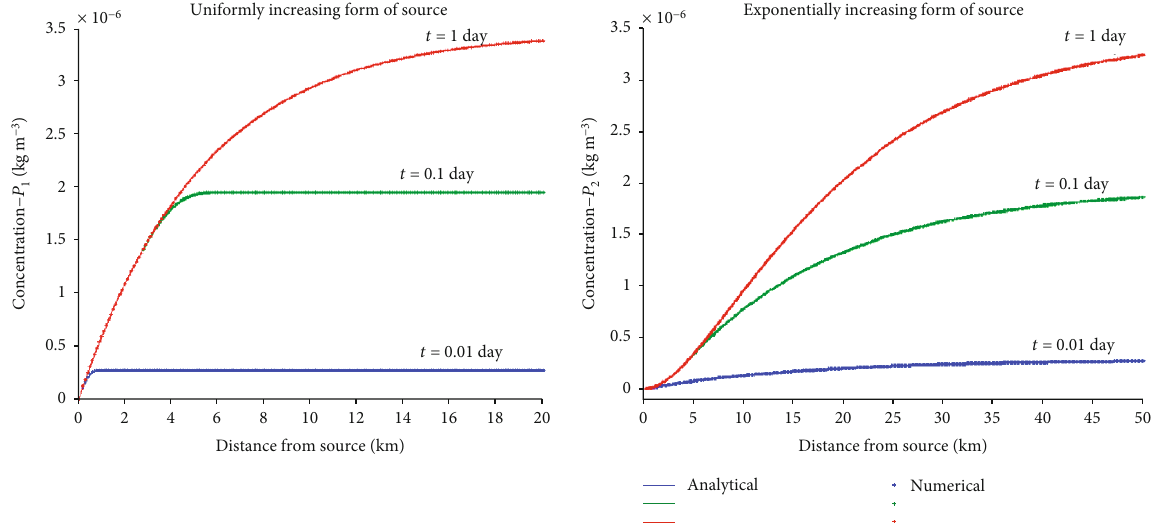
Figure 4: Analytical and numerical solutions of pollutant concentrations P